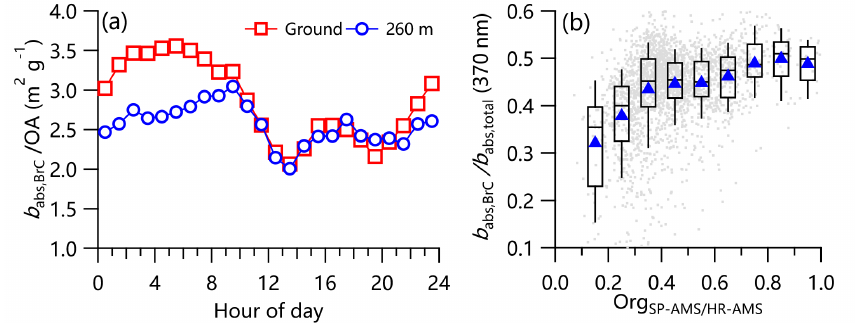
Figure 11. (a) Diurnal cycles of b abs , BrC / OA, i.e., MAC org , 370nm at ground level and 260m, (b) variations of the ratio of BrC absorption to the total absorption at 370nm as a function of the ratio of organics between SP-AMS and HR-AMS. The data are binned according to O / C. The median (horizontal line), mean (triangle), 25th and 75th percentiles (lower and upper box), and 10th and 90th percentiles (lower and upper whiskers) are also shown.